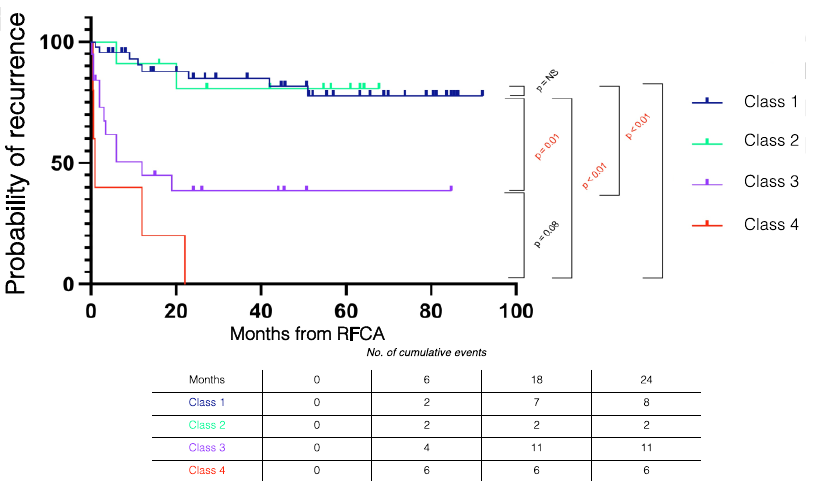
Figure 5. Kaplan–Meier recurrence curves stratified by procedural outcome. RFCA = radiofrequency Figure 5. Kaplan – Meier recurrence curves stratified by procedural outcome. RFCA = radiofre- catheter quency catheter ablation.